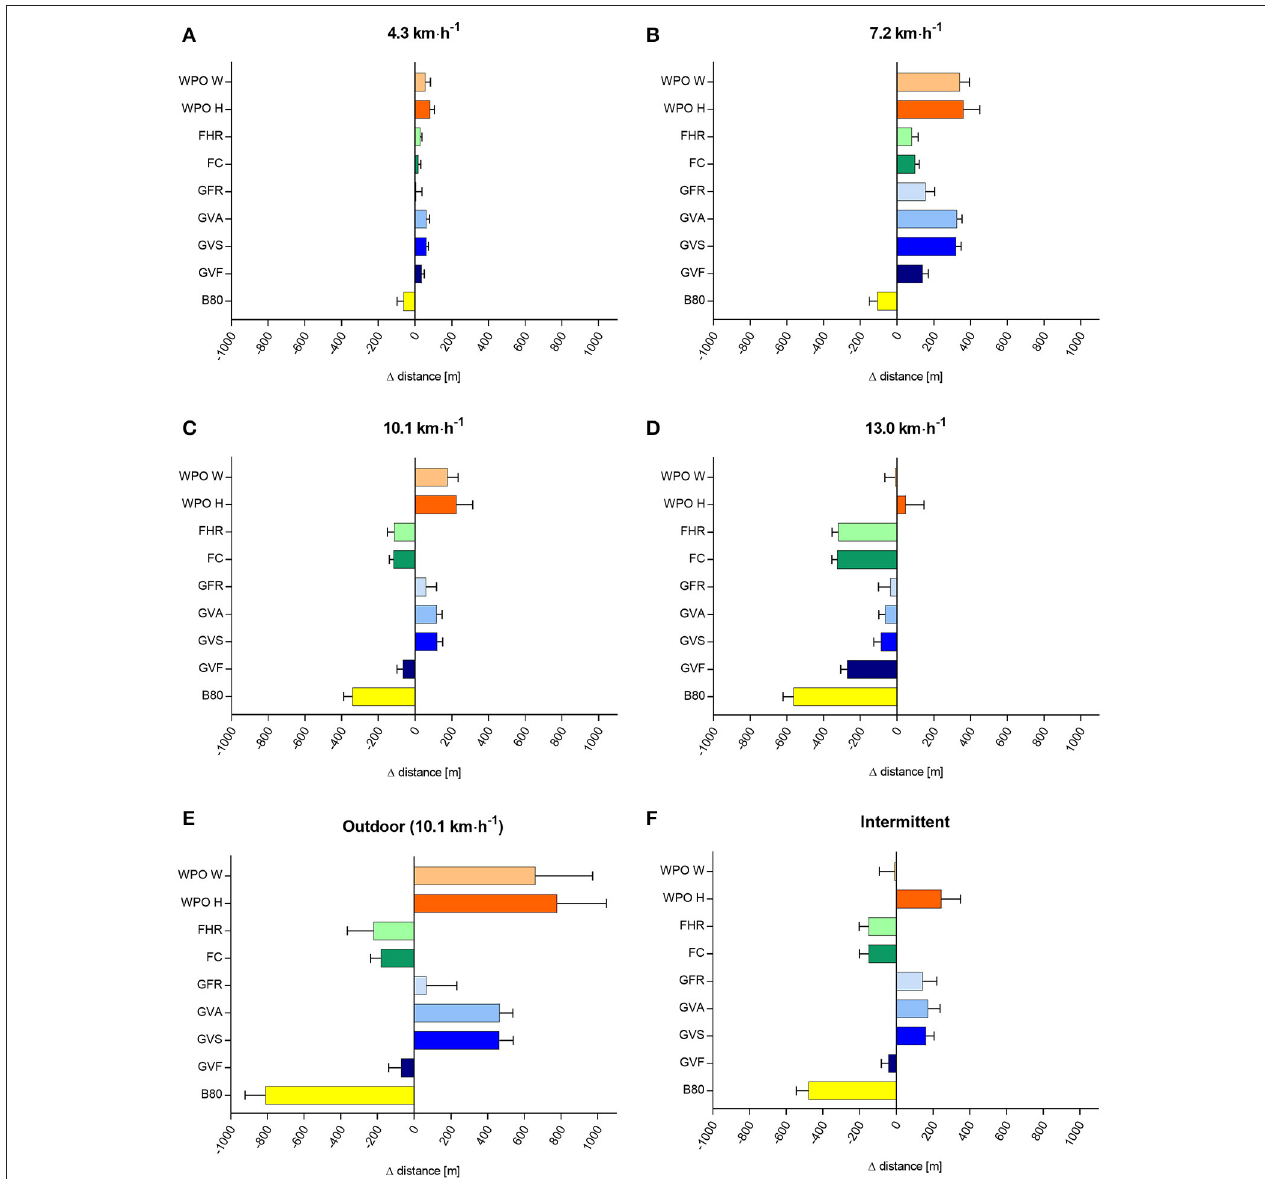
FIGURE 3 | Difference in covered distance (m) between the criterion measure and the nine activity trackers at different running velocities (A–F) , data are shown as mean 95% CI. Mean covered distance ( ± km h − 1 1,088 21; intermittent · = ± Vivoactive; GFR, Garmin Forerunner 920XT; FC, Fitbit Charge; FHR, Fitbit Charge HR; WPO H, Withings Pulse O x Hip; WPO W, Withings Pulse O x